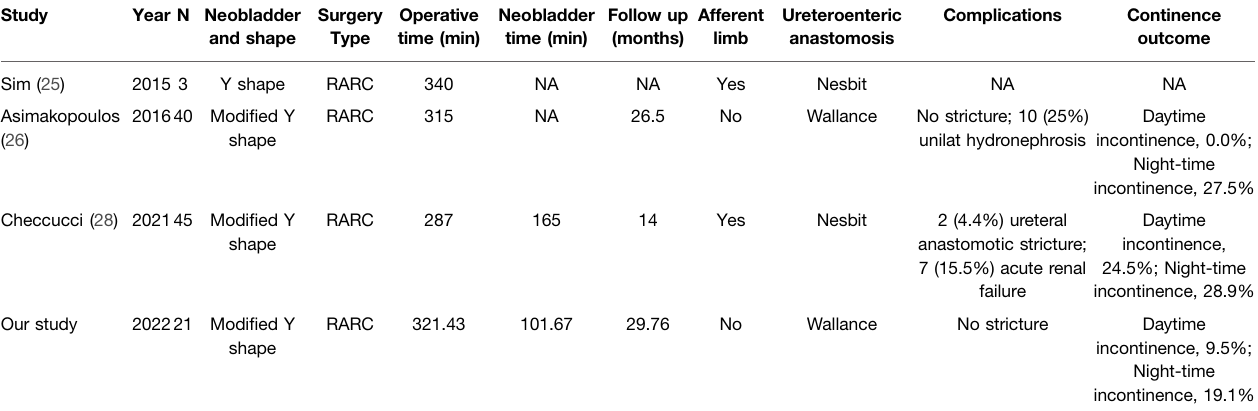
TABLE 6 | Evaluation of the effectiveness of several robotic-assisted Y-shaped ileal orthotopic neobladder.